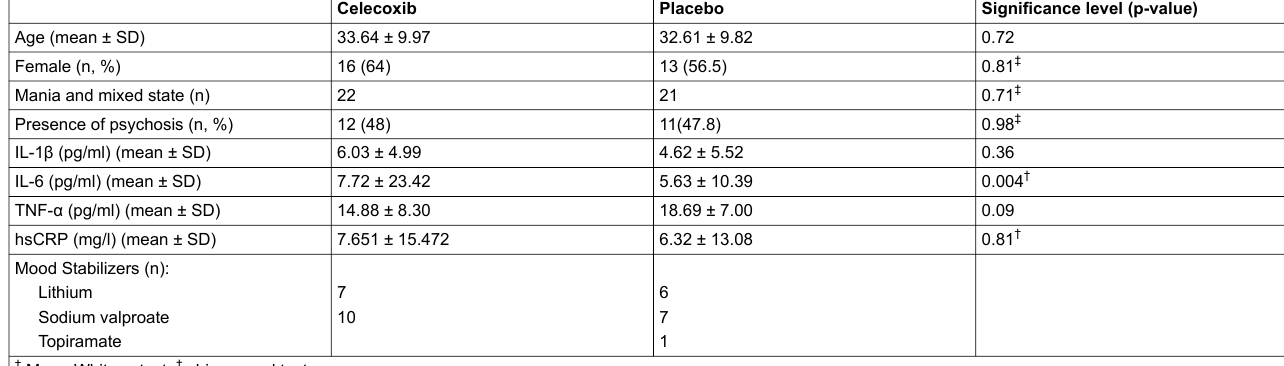
Table 1: Demographic characteristics and baseline serum cytokine and hsCRP levels in patients receiving celecoxib (n = 25) and placebo (n = 23). Celecoxib Placebo Significance level